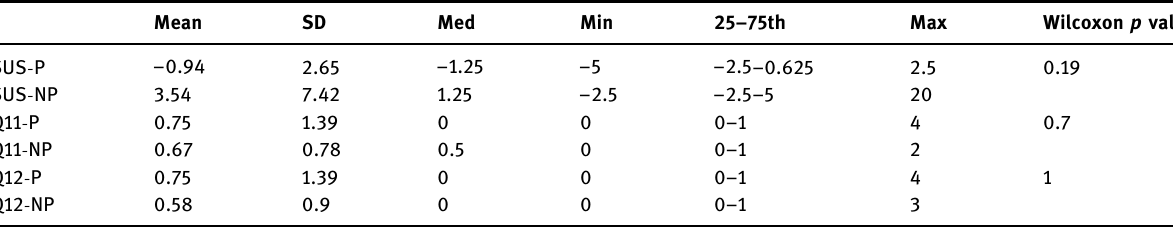
Table 13: Outcome di ff erences between the two repeated measures conditions according to participants with and without prior robot programming experience Mean